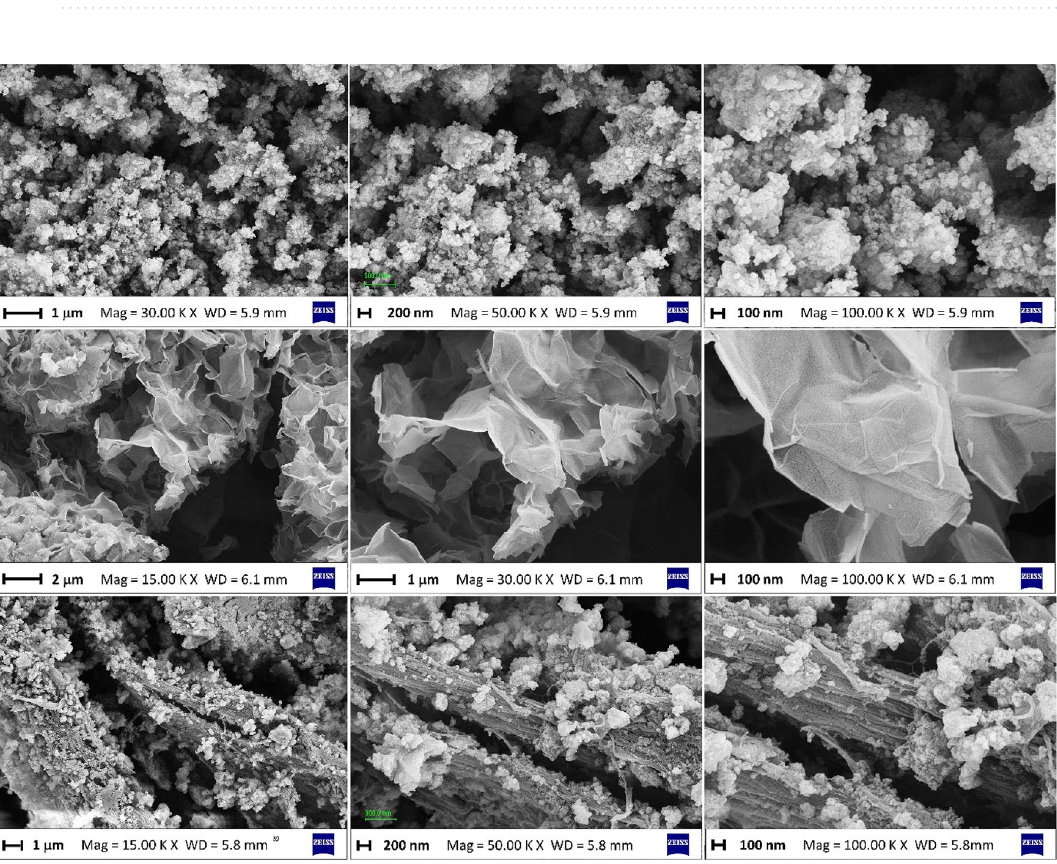
Table 1. Absorption bands observed in FT-IR spectra of the samples ( OL overlapped).